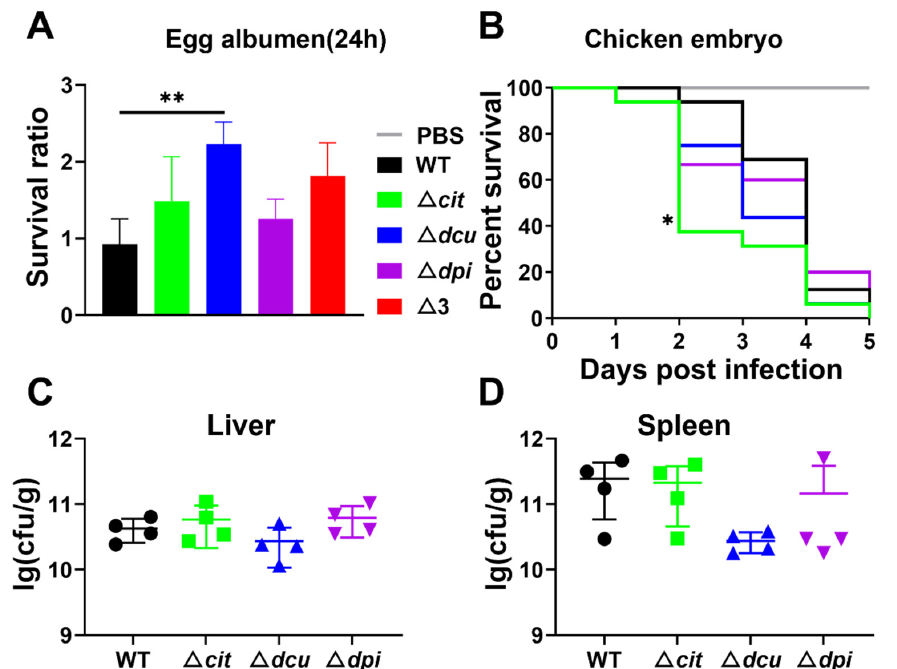
Figure 4. Deletion of TCSs of the CitB family increased the growth in egg albumen and virulence of the chicken embryo. ( A ) The survival of WT and mutants after 24 h cultured in egg white at 37 °C and the ratio calculated as CFU (colony forming units) at 24 h/CFU at 0 h. ( B ) Survival curves for chicken embryos infected with WT and mutants. Sixteen-day-old chicken embryos were inoculated, each strain with 50 CFU via allantoic cavity injection and monitored for five days until hatching out of the shell. ( C , D ) Bacterial loads in liver ( C ) and spleen ( D ) tissues of infected embryos 5 days post-infection. Statistical significance of differences was evaluated by one-way ANOVA test (* p < 0.05; ** p < 0.01).